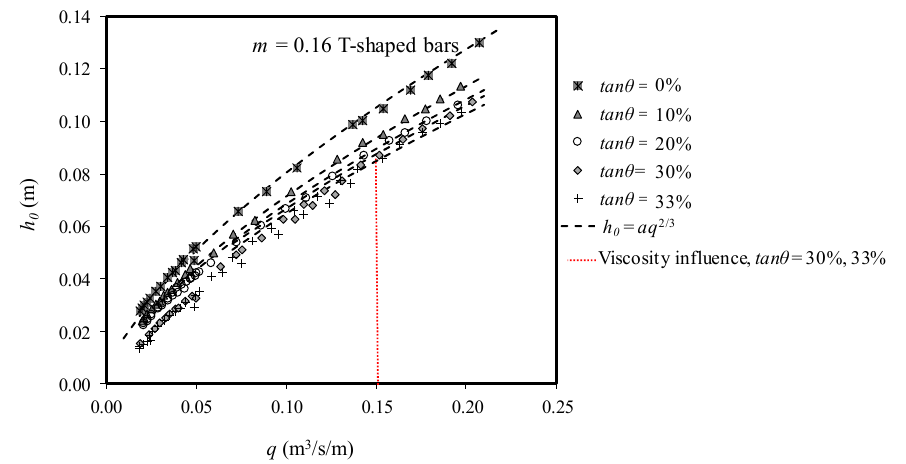
Figure 8. Flow depth at the beginning of the rack h 0 as a function of the incoming flow q . Circular bars with void ratio m = 0.60.